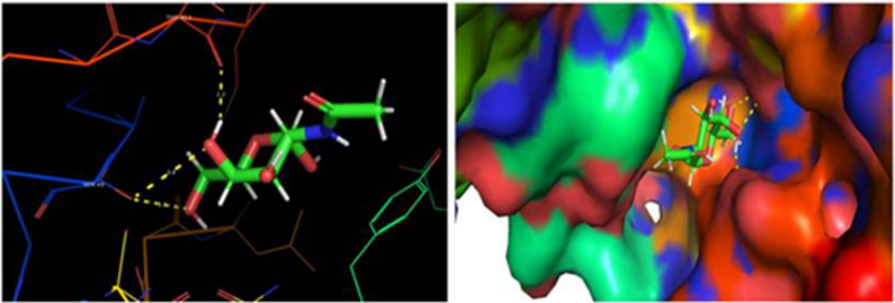
Table 2. Molecular interaction of 2-acetamido-2-deoxy-hexopyranose with the binding pocket of penicillin-binding protein.